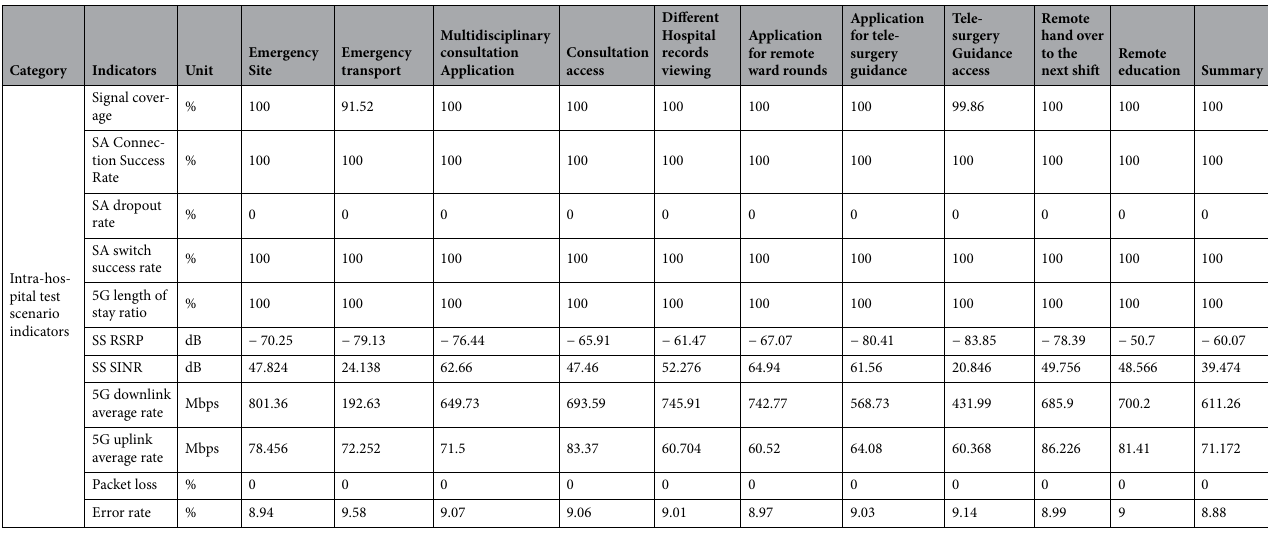
Table 3. Intra-hospital scenario indicator test results.